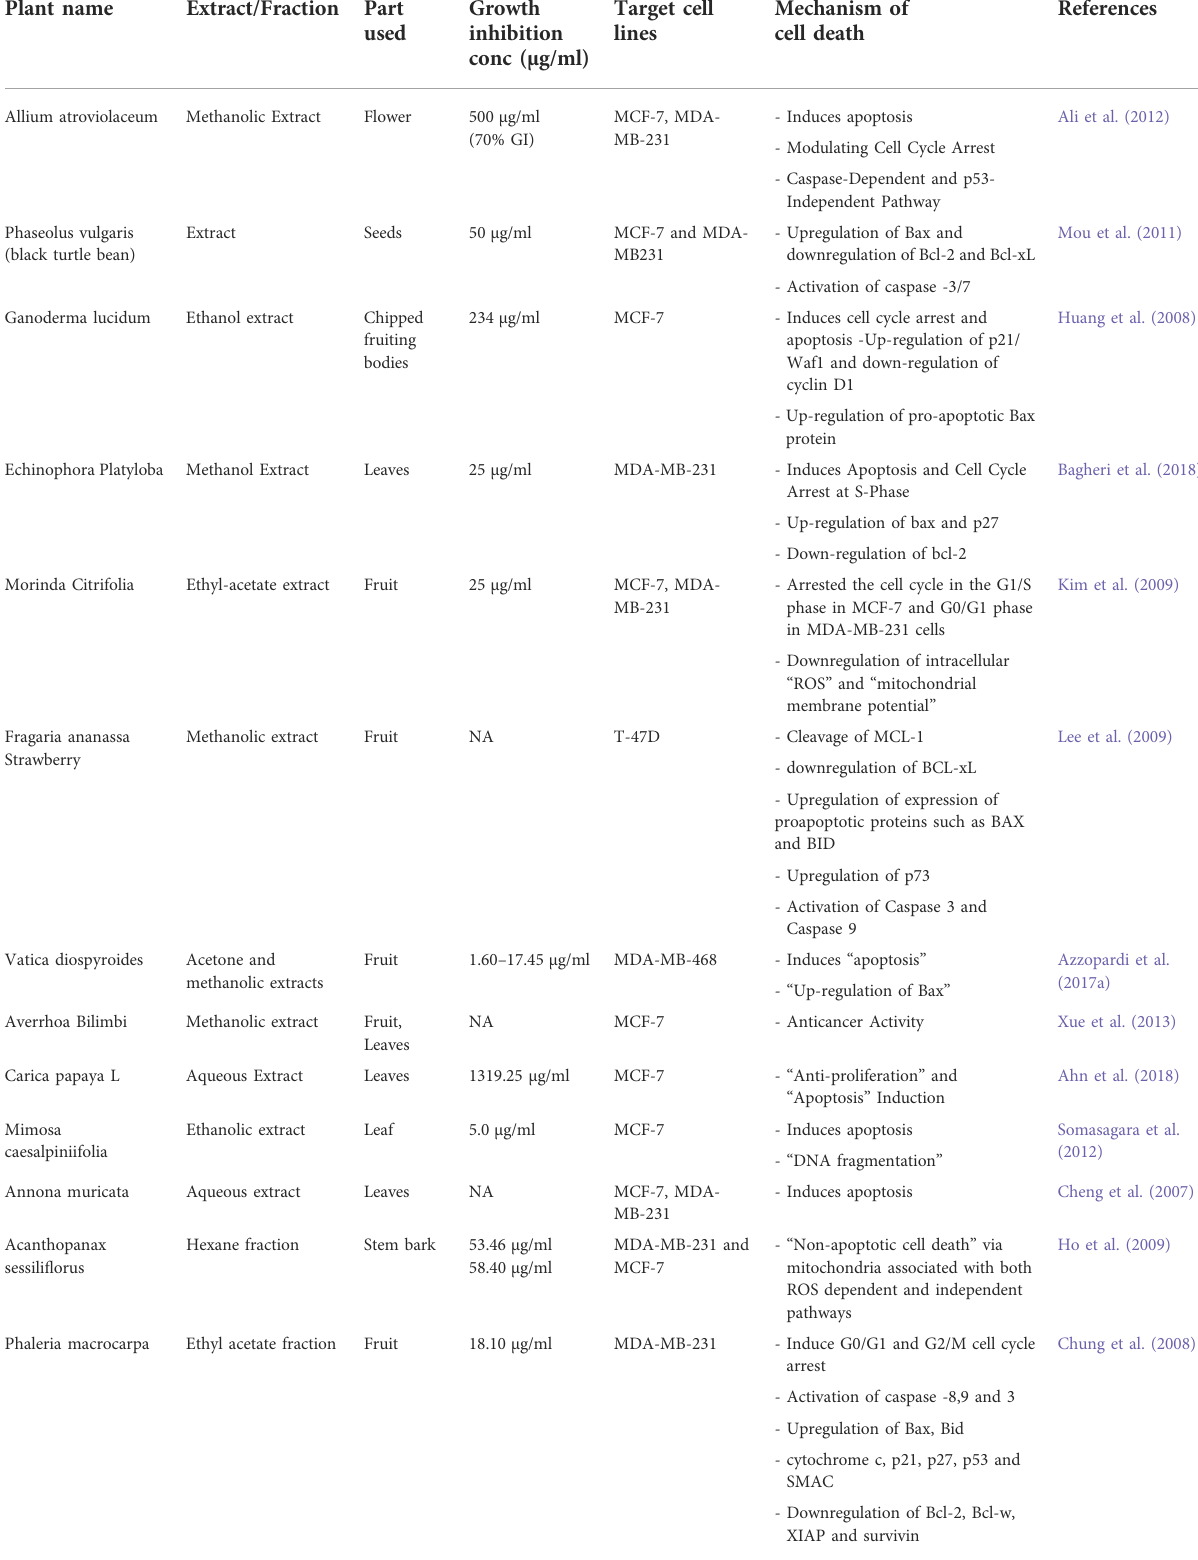
TABLE 1 Plant extracts/fractions as apoptotic inducers for breast cancer ( in vitro ). updated and improved from (Israels and Israels,